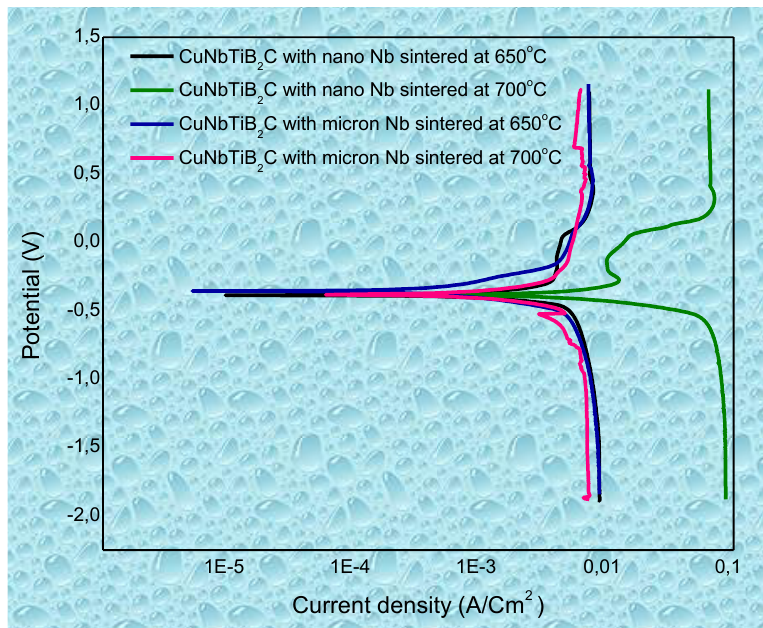
Figure 8. Shows the comparison of the potentiodynamic polarization curve of the novel multi- principal alloys of CuNbTiB 2 C in 1 mole H 2 SO 4